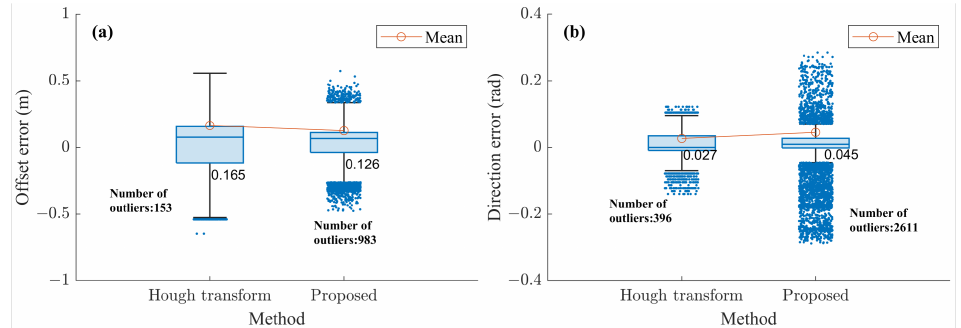
Figure 16. The error of the proposed method and the Hough transform method for dataset 2: ( a ) offset error; ( b ) direction error.